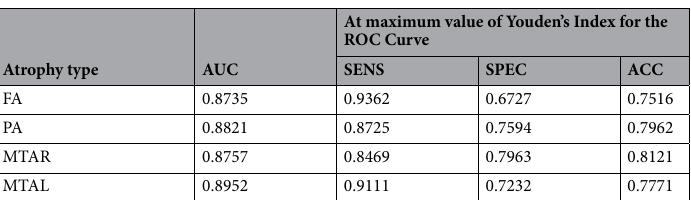
Atrophy type AUC